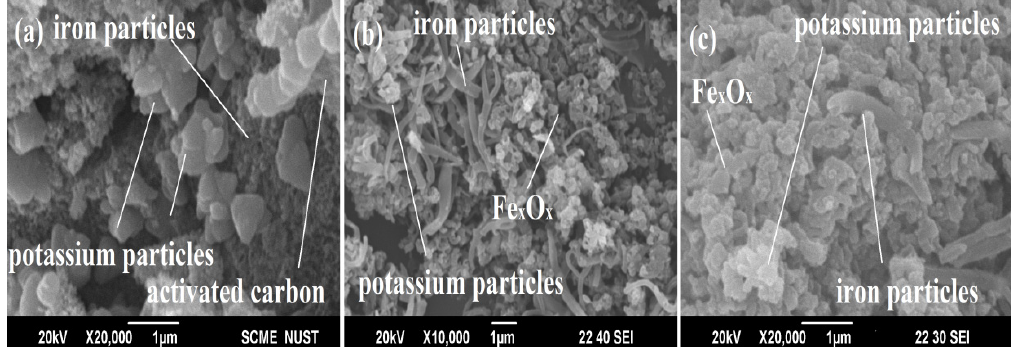
Figure 3. Scanningelectron microscopy of Fe-C catalyst ( a ), Fe-C LT-FTS ( b ), and Fe-C HT-FTS ( c ) .